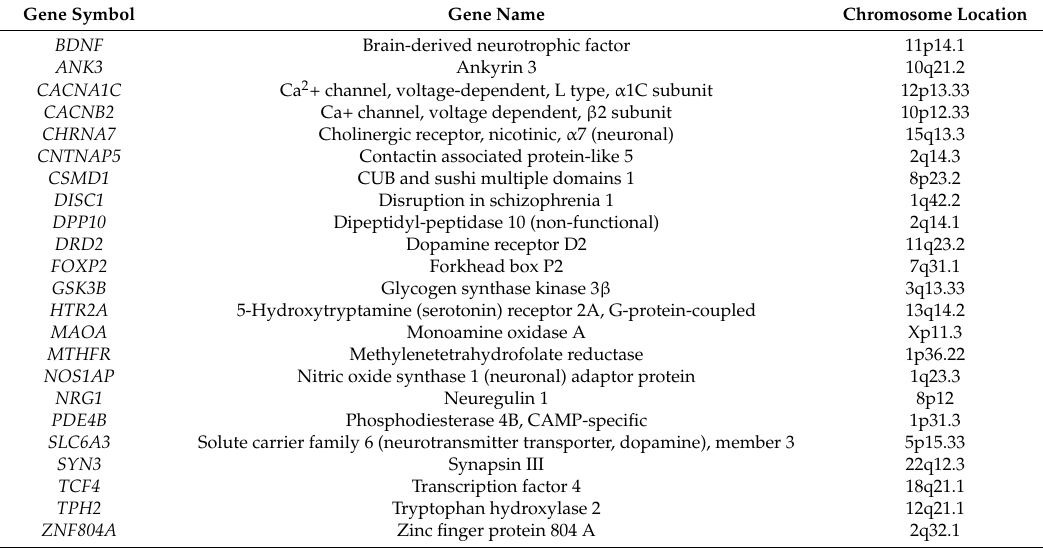
Table 1. Twenty-three clinically relevant genes common to ASD, BPD and schizophrenia.